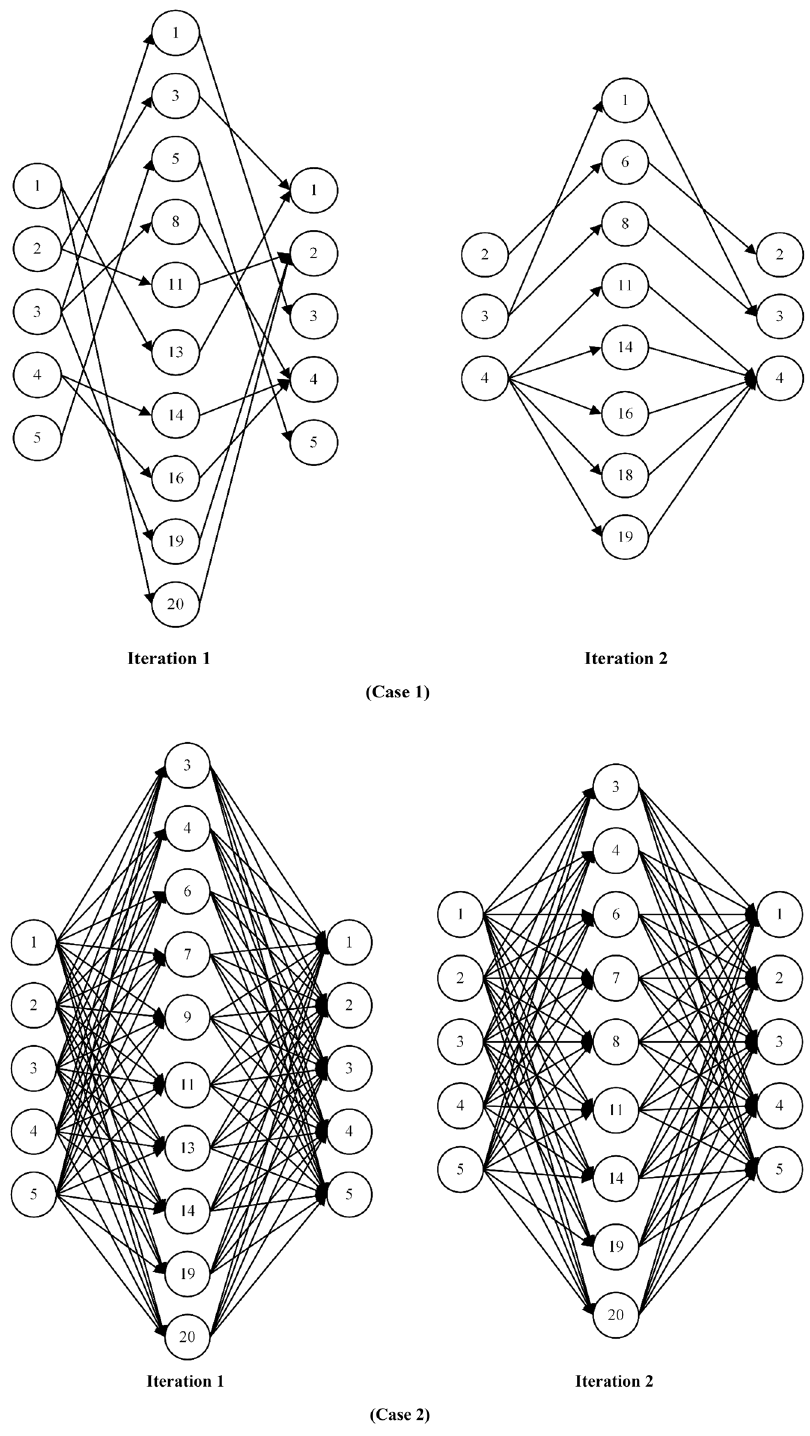
Figure 7. Members participating in the blockchain